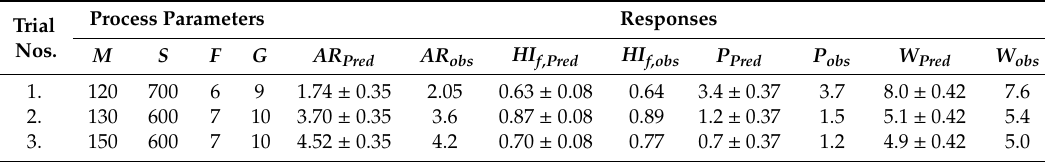
Table 3. Model validation and